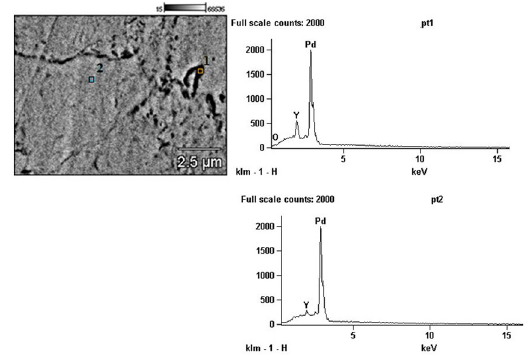
Y oxidized at 800ºC 0.97 0.03